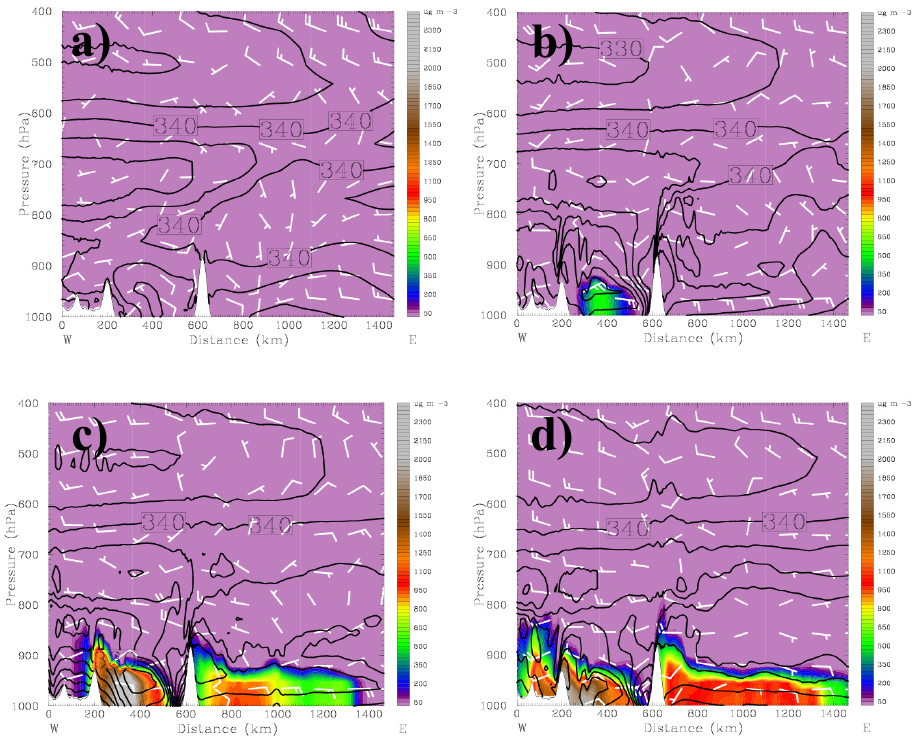
Fig. 13. The cross-section distribution of wind field, theta-e (contour) and PM 10 concentration along EW2 in Fig. 9 at (a) 18:00UTC, 20 March (b) 00:00UTC, 21 March (c) 06:00UTC, 21 March (d) 12:00UTC, 21 March. A full (half) wind barb indicates 5ms − 1 (2.5ms − 1